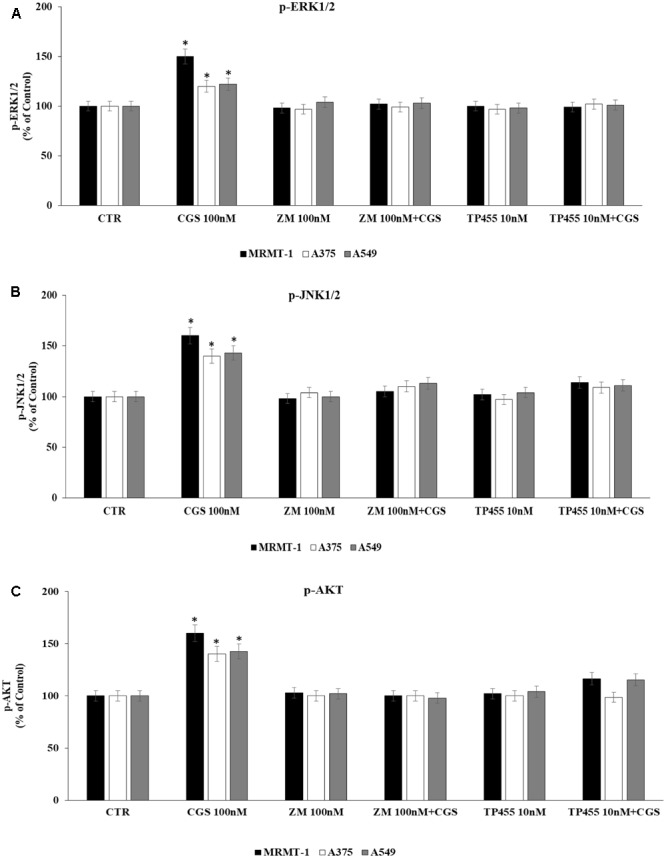
Effect of antagonists on CGS 21680-dependent pERK1/2, pJNK MAPK kinase, and pAKT activation. MRMT-1, A375, and A549 cells in the absence or in the presence of 100 nM ZM 241385 and 10 nM TP455 were exposed to 100 nM CGS for 5 min or for 30 min and pERK1/2 (A), pJNK (B), and pAKT (C) protein levels were evaluated by AlphaScreen SureFire pMAPK assays respectively. Solutions were made up in DMSO and then diluted in cell culture medium (0.1 max 0.2% of DMSO). An equal amount of DMSO was used in control cells (CTR). ∗P < 0.01 compared with CGS 21680 100 nM. Means ± SE values from four experiments are shown. Analysis was by one-way ANOVA followed by Dunnett’s test.